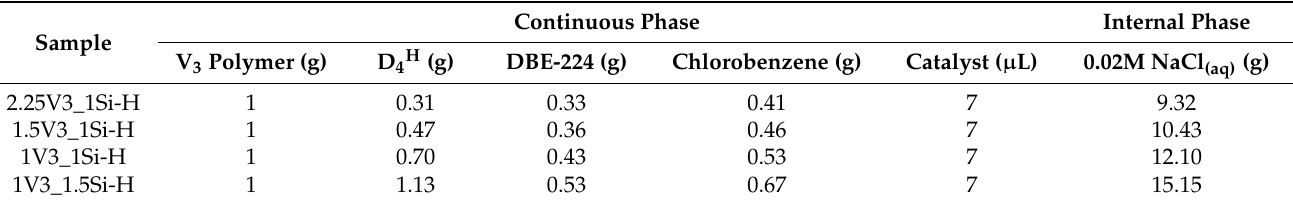
Table 1. Amounts of components used in the preparation of the studied